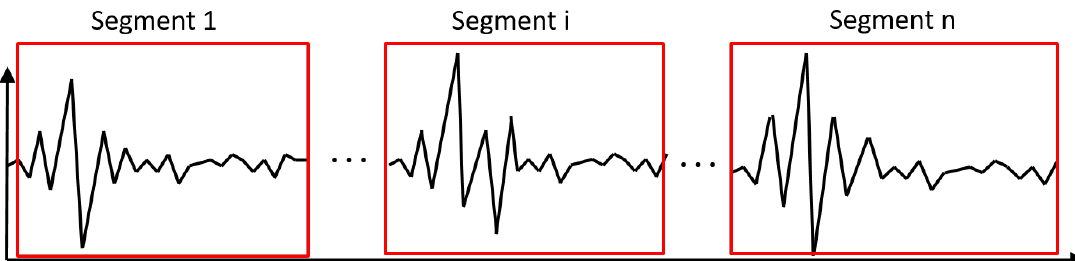
Figure 6. The idea of segment